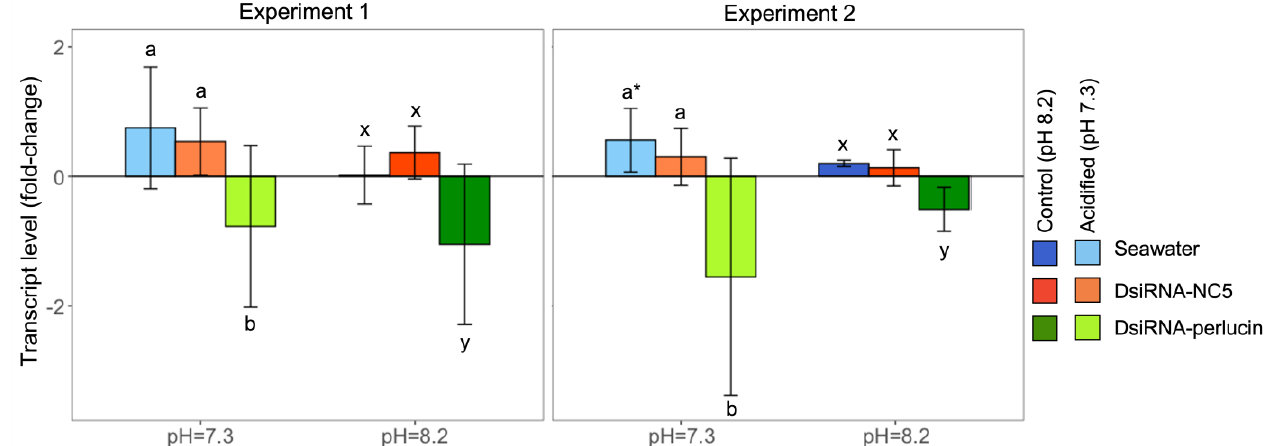
Figure 2. Relative change in perlucin expression (mean ± sd) among silenced oysters (DsiRNA-perlucin (green)) compared to controls (DsiRNA-NC5 (orange) and seawater (blue)) grown at pH = 7.3 (lighter shades) or pH = 8.2 (darker shades). Different letters (a and b for pH 7.3 and x and y for pH 8.2) indicate significant differences within each pH group (1-way ANOVA followed by Student–Newman–Keuls post hoc tests, n = 3 pools of larvae per data point). The * denotes significant over-expression of perlucin among non-silenced oysters (treated with seawater) grown under acidified conditions (pH = 7.3) as compared to those cultured at pH = 8.2 ( t -test, p < 0.05). Oysters were sampled on day 3 for Experiment 1 and day 5 for Experiment 2.